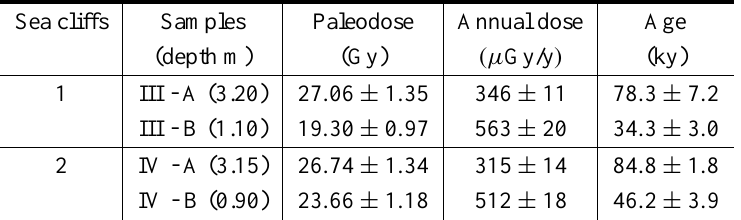
Sample names, paleodoses, annual doses and ages of sediments collected in the southernmost tip of the Comprida island.